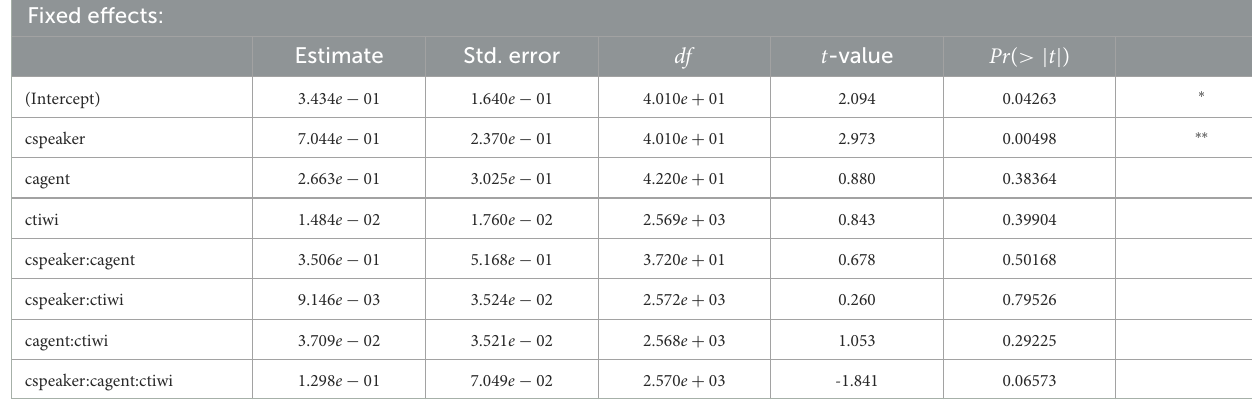
TABLE 4 Coefficients, SE s, df s, t -values, and p -values for the optimal model of logratios of target fixations for the NP2 time window for Experiment